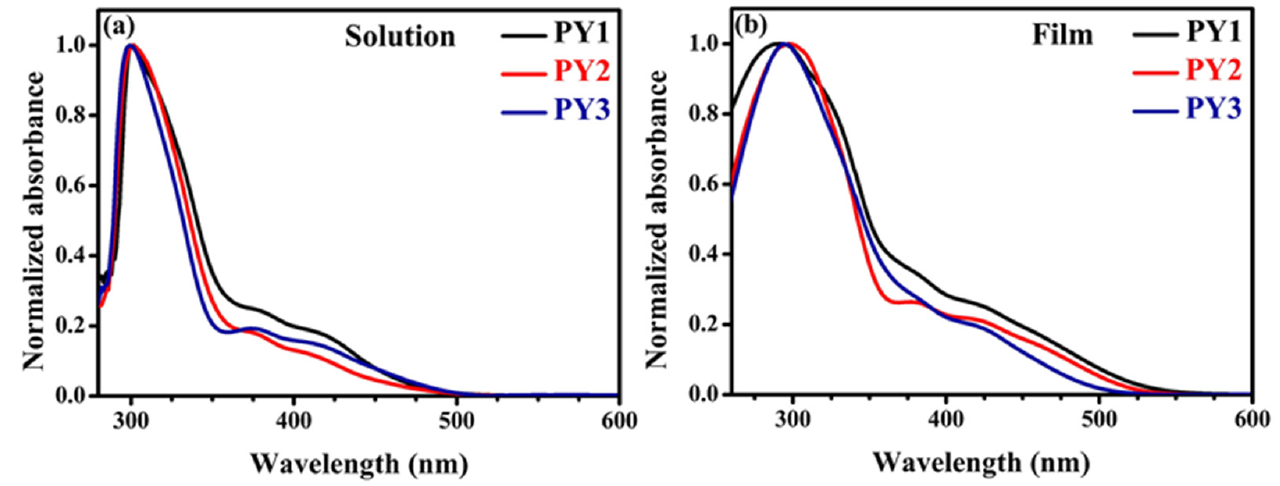
Figure 2. Normalized UV–visible absorption spectra in THF ( a ) and in thin film ( b ) of PY1 – PY3 . Figure 3a depicts the cyclic voltammetry (CV) measurements of PY1 , PY2 and PY3